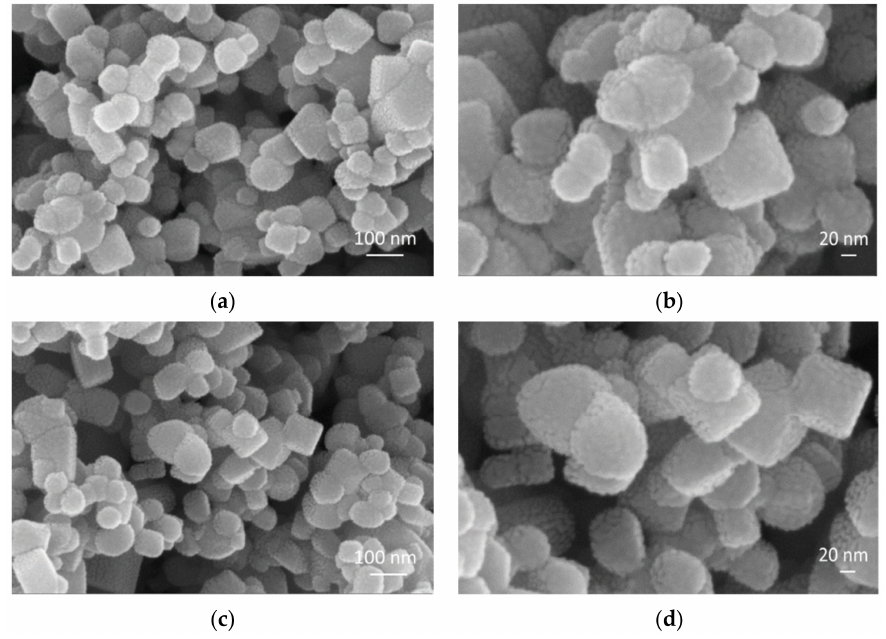
Figure 1. FESEM images of pure TiO 2 and Ag-TiO 2 : ( a ) and ( b ) pure TiO 2 , ( c ) and ( d ) Ag-TiO